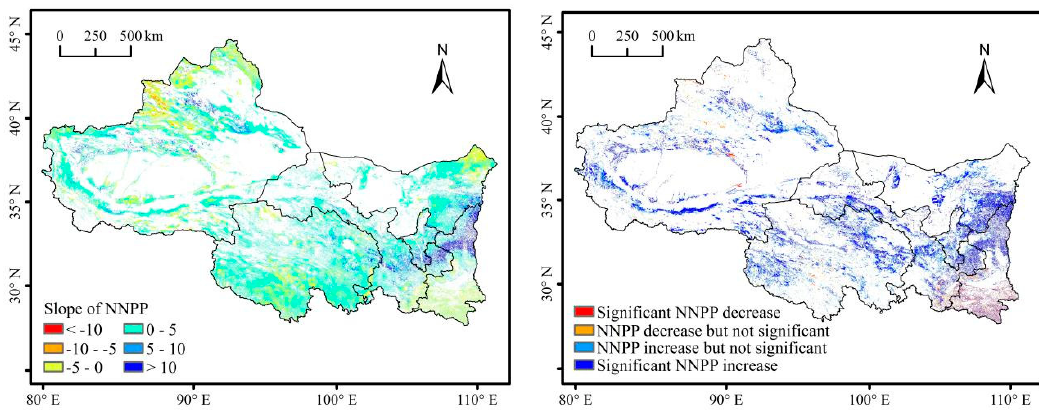
Figure 9. Changes in annual mean NNPP and PNPP.